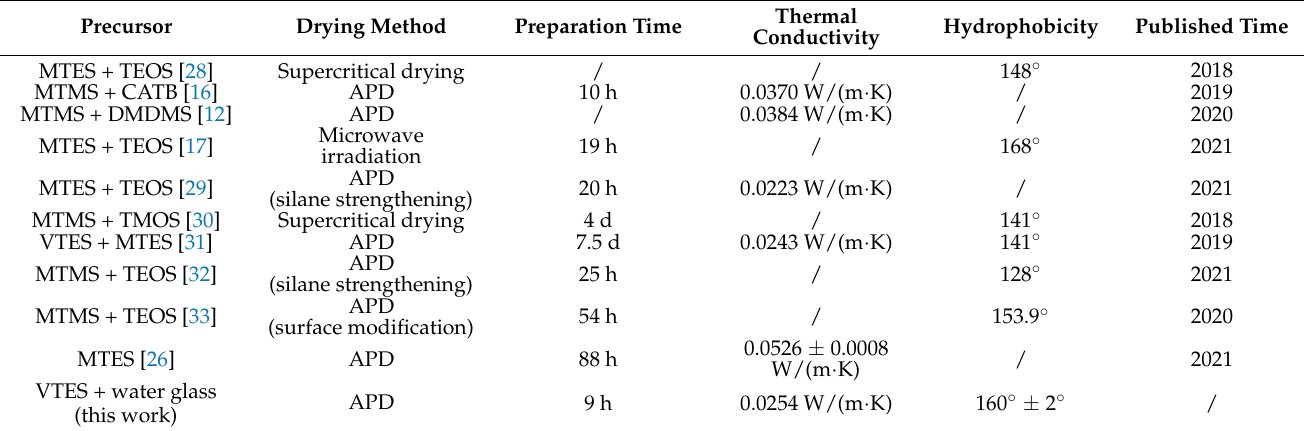
Table 1. Comparison of aerogel samples that are prepared by using different